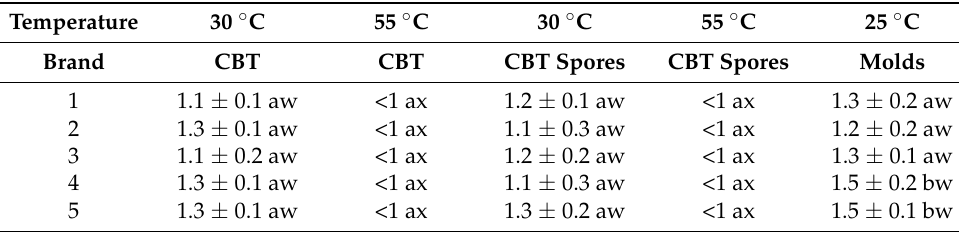
Table 7. Microbial population in chocolate of 5 different brands sold in the Italian market.